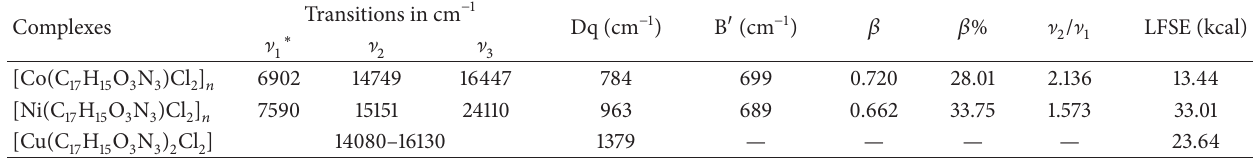
∗ Calculated values. Empirical formulae of the complexes